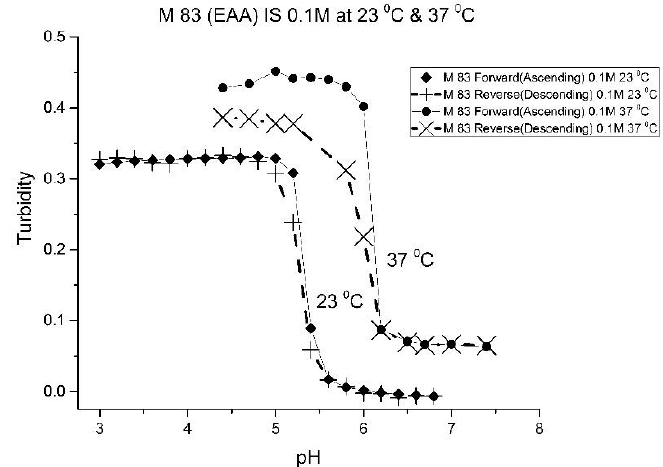
Figure 3. Ascending and descending pH profiles of polymer particles of M-83 (NIPA copolymerized with EAA) at 23 °C and 37 °C. Solid line = ascending pH profile. Dashed line = descending pH profile.